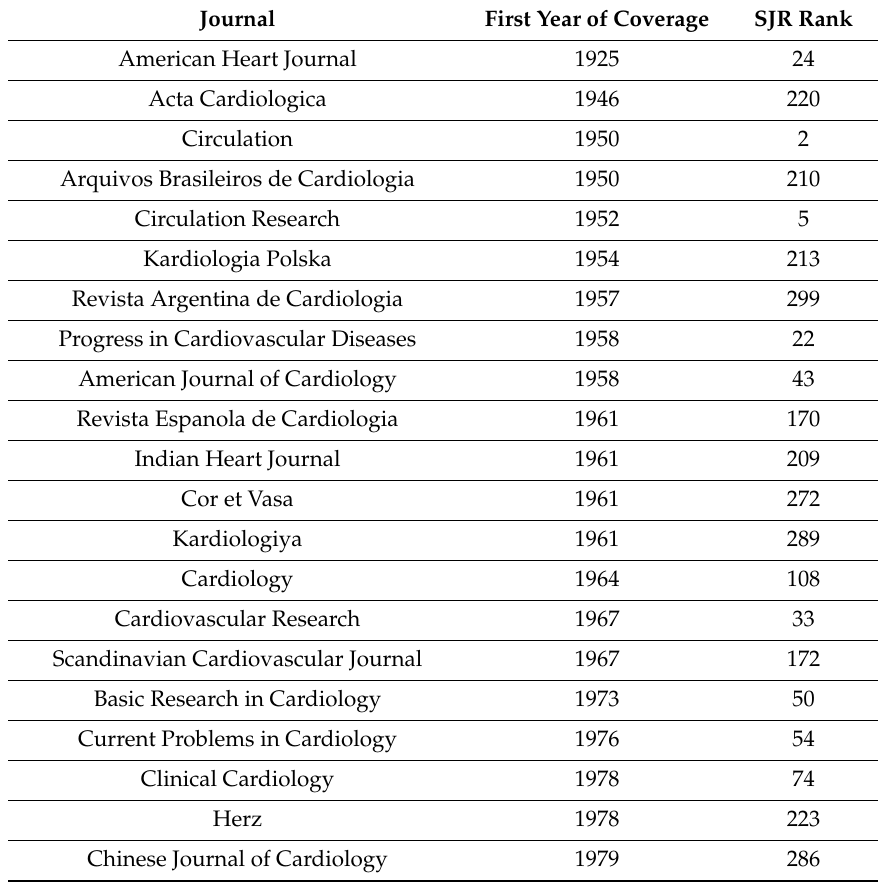
Table 2. New foundations of cardiological journals before